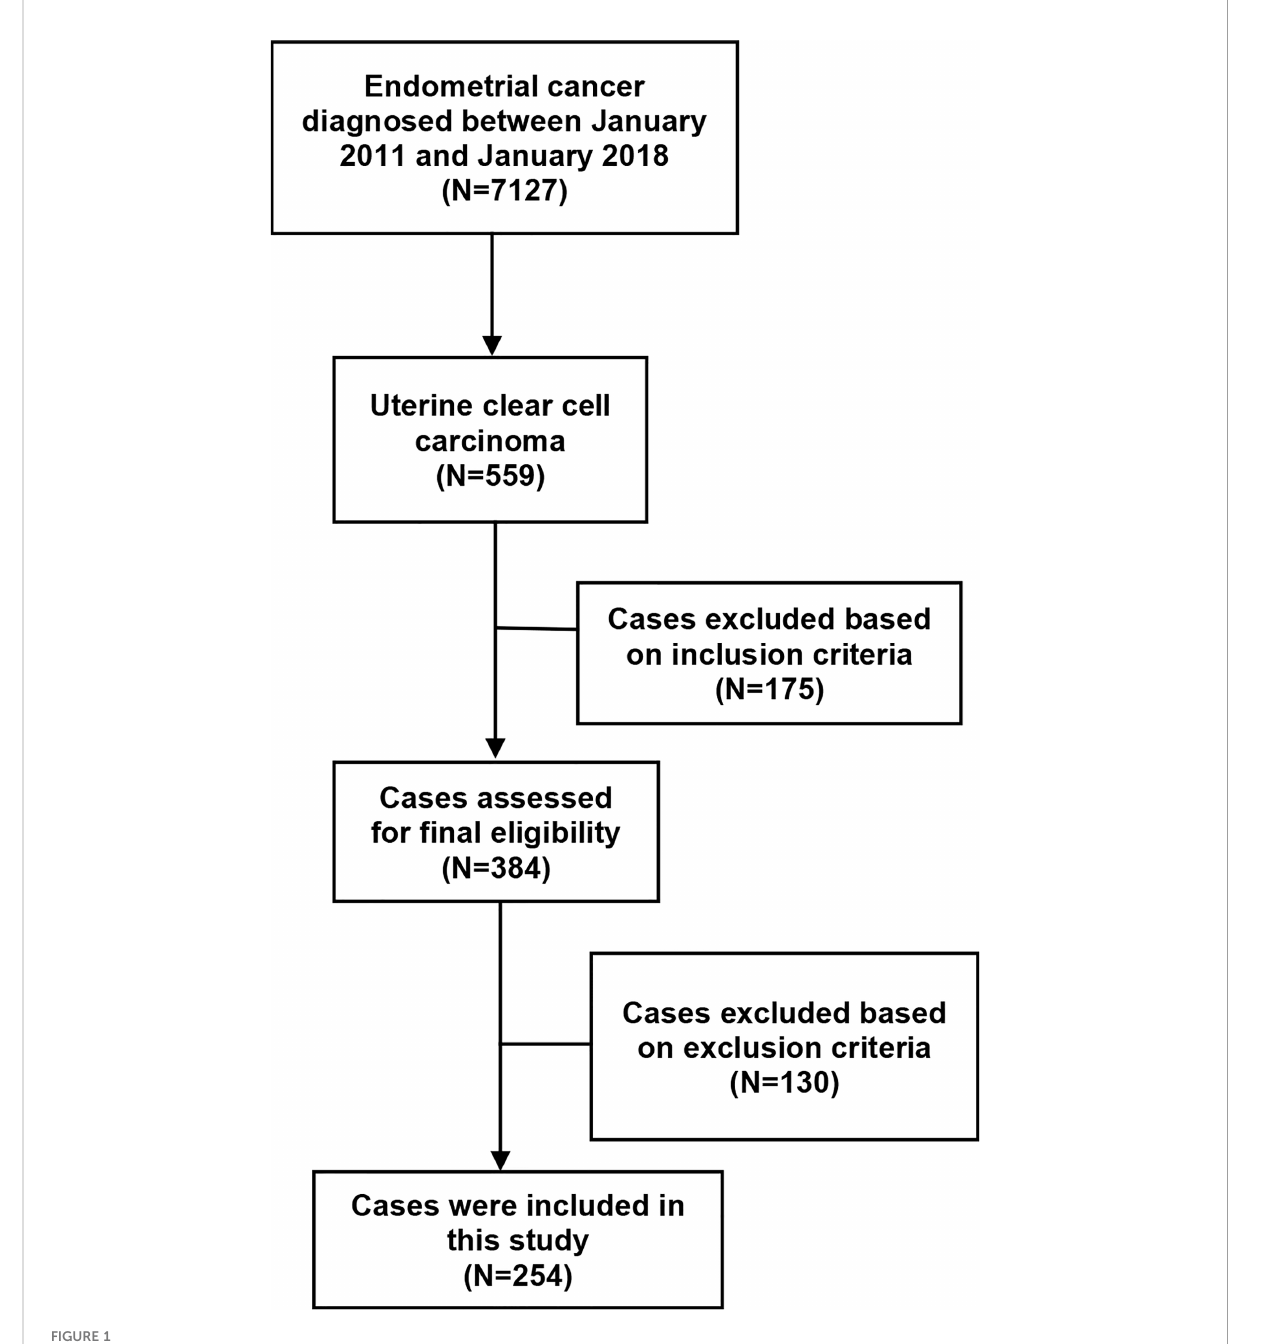
FIGURE 1 The fl owchart of case